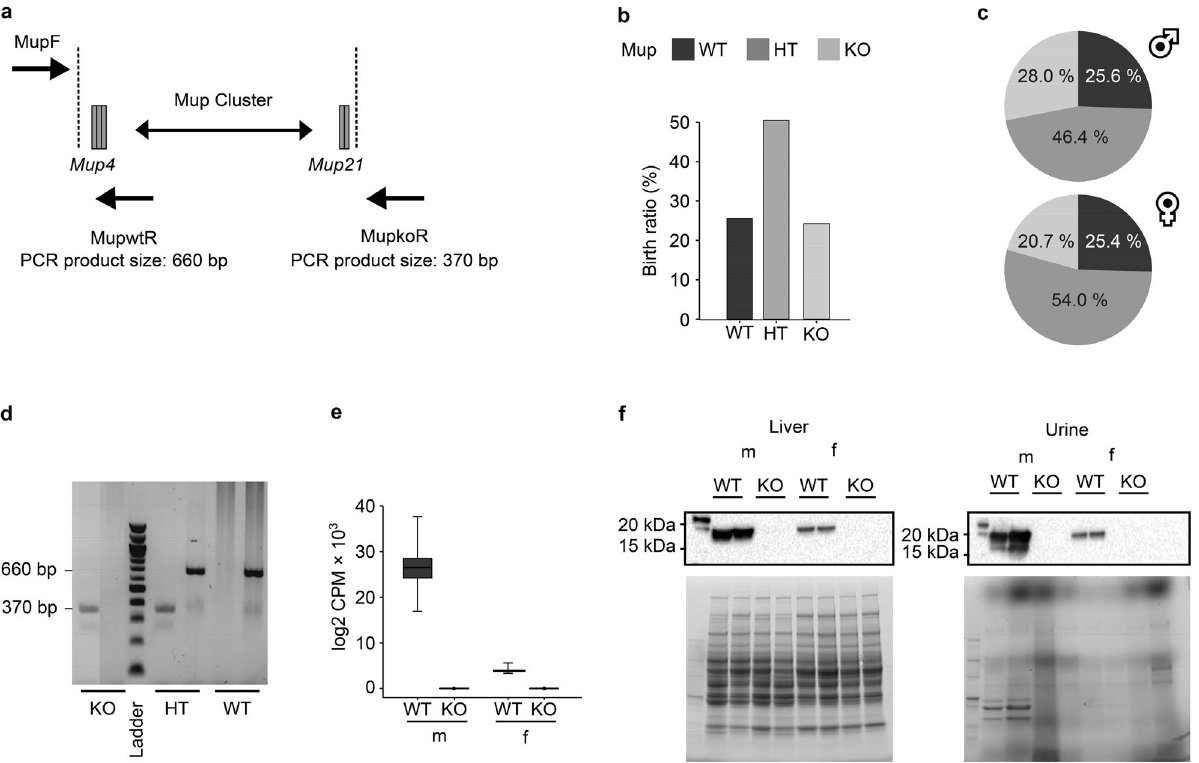
Figure 1. Generation and confirmation of the Mup knockout (KO) mouse model and corresponding genotype birth ratio in the colony. ( a ) Schematic representation of the Mup gene cluster on chromosome 4 with Cas9 cleavage sites (dashed lines) and primer binding sites for genotyping (single-headed black arrows). ( b ) Overall genotype birth ratio of the Mup-KO mouse line (n = 1048). ( c ) Sex-specific genotype birth ratio in male (m; n = 496) and female (f; n = 552) mice. ( d ) Representative PCR products of genotyped homozygous (KO), heterozygous (HT), and wildtype (WT) animals on an agarose gel. Primer pairs were tested separately (left lane: KO (370 bp); right lane: WT (660 bp)). ( e ) Hepatic total Mup mRNA expression levels in log2 counts per million (CPM) in male (m) and female (f) KO and WT mice quantified by RNAseq. Data are presented as Spear style boxplots, where the whiskers indicate the minimum and maximum value, and lower and upper hinges correspond to the upper and lower quartiles, and the center line to the median (mWT = 6, mKO = 5, fWT = 6, fKO = 6). ( f ) Representative Western blots (cropped; original blot membranes: Supplementary Fig. S1a) of total Mup protein levels in liver cytosolic fraction and spot urine of male and female KO and WT mice including the respective protein loading control on stain free polyacrylamide gels (cropped, original stain free polyacrylamide gel: Supplementary Fig. Male but not female Mup‑KO mice display differential hepatic gene expression related to lipid metabolism compared to the respective WT mice. A hepatic RNAseq analysis of KO and WT mice was performed to explore the formerly described anabolic changes on a molecular level. Of the 16,267 genes expressed in the liver of KO and WT mice, 461 differentially expressed genes (DEG) were found in mKO and 137 DEG were identified in fKO animals compared to mWT and fWT mice, respectively (Fig. 4a, Dataset S1). The DEG in mKO mice may explain the different phenotypes observed in mKO and mWT mice as principal component analysis of gene expression data discriminates between mKO and mWT but not between fKO and fWT animals (Fig. 4b). Overlapping downregulated DEG between mKO and fKO mice were limited to the deleted Mup gene cluster (Mup1–Mup22) whereas interleukin-1 receptor accessory protein (Il1rap) and Spry domain-containing protein 7 (Spryd7) were the only upregulated DEG overlapping between males and females. Also, DEG analysis revealed sex-specific unique gene expression patterns with 203 uniquely down- and 234 uniquely upregulated genes in mKO mice and 42 uniquely down- and 69 uniquely upregulated genes in fKO mice (Fig. 4c). Monoacylglycerol O-acyltransferase 1 (Mogat1), apolipoprotein A II (Apoa2), elongation of very long chain fatty acids protein 3 (Elovl3), and glutamate-cysteine ligase catalytic subunit (Gclc) were identified among the top upregulated DEG, while cholesterol 7 alpha-hydroxylase (Cyp7a1) was among the top downregu- lated DEG in the mKO vs. mWT comparison. None of these genes were significantly regulated between fKO and fWT mice (Fig. 4c). Peroxisome proliferator-activated receptor alpha (Pparα) and nuclear factor, erythroid- derived 2-like 2 (Nfe2l2) were observed as the most relevant hepatic upstream regulators activated in mKO mice (Fig. 4d). Of the 29 identified DEG associated with Pparα signaling in mKO mice, the differential regulation of 19 genes in the data set was in accordance with the curated IPA prediction based on the literature. Similarly, of the 29 identified DEG associated with Nfe2l2 signaling in mKO mice, the differential regulation of 23 genes in